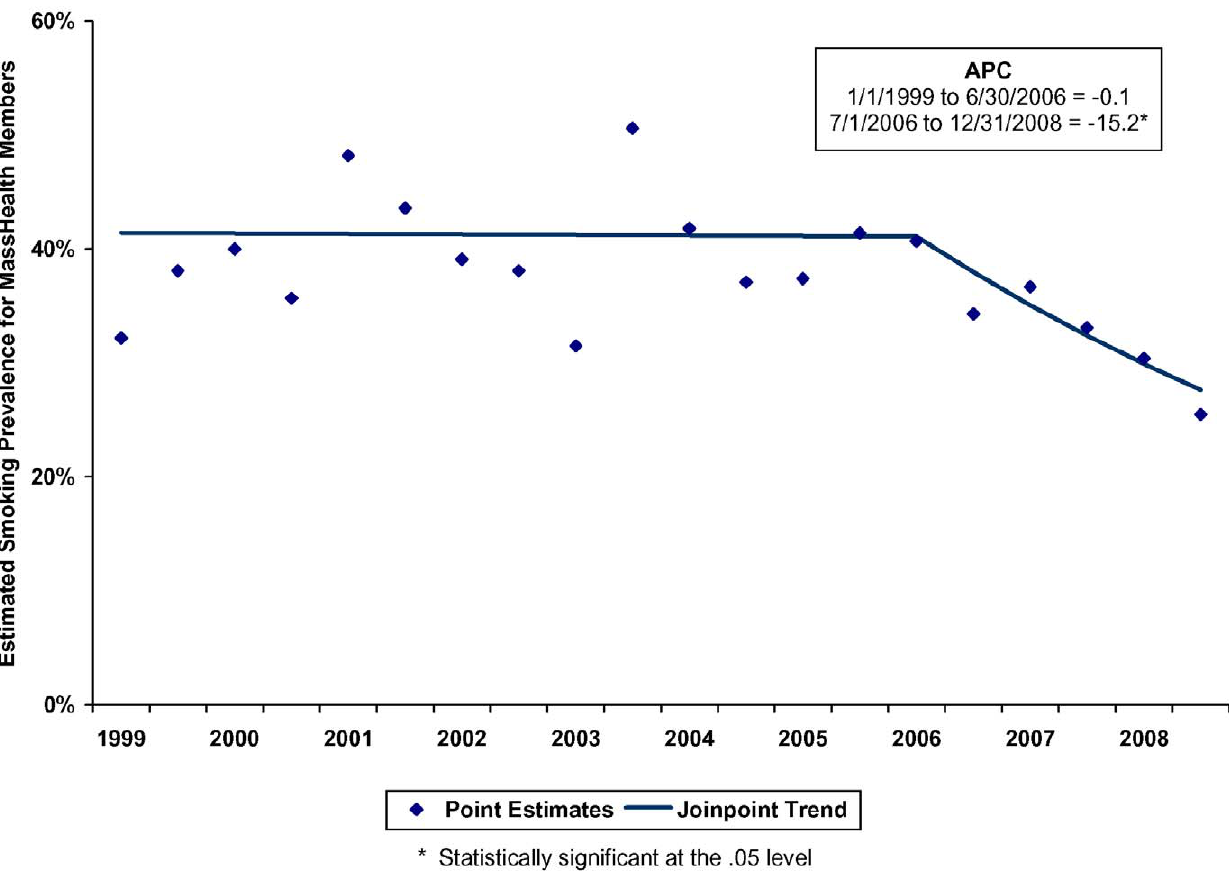
Figure 1. Demographic-Adjusted Smoking Prevalence of MassHealth Members, Age 18–64, 1999 to 2008 (Joinpoint Trend). (1) The diamonds on the chart represent the 6-month smoking prevalence estimates based on responses to the BRFSS. Initial weighting of prevalence estimates used a standard BRFSS weighting scheme in which data are directly weighted for the probability of selection of a telephone number, the number of adults in a household, and the number of telephones in a household. A final post-stratification adjustment is made for non-response and non-coverage of households without telephones. Data were also weighted in such a way to force prevalence estimates to match demographic characteristics for the period from 1/1/2003 through 6/30/2006. (2) The lines on the chart represent the smoking prevalence trends for the MassHealth population as estimated by the joinpoint analysis. The period between 1/1/1999 and 6/30/2006 showed no significant change (p=0.93). Beginning 7/1/2006, there was a significant downward trend (p ,